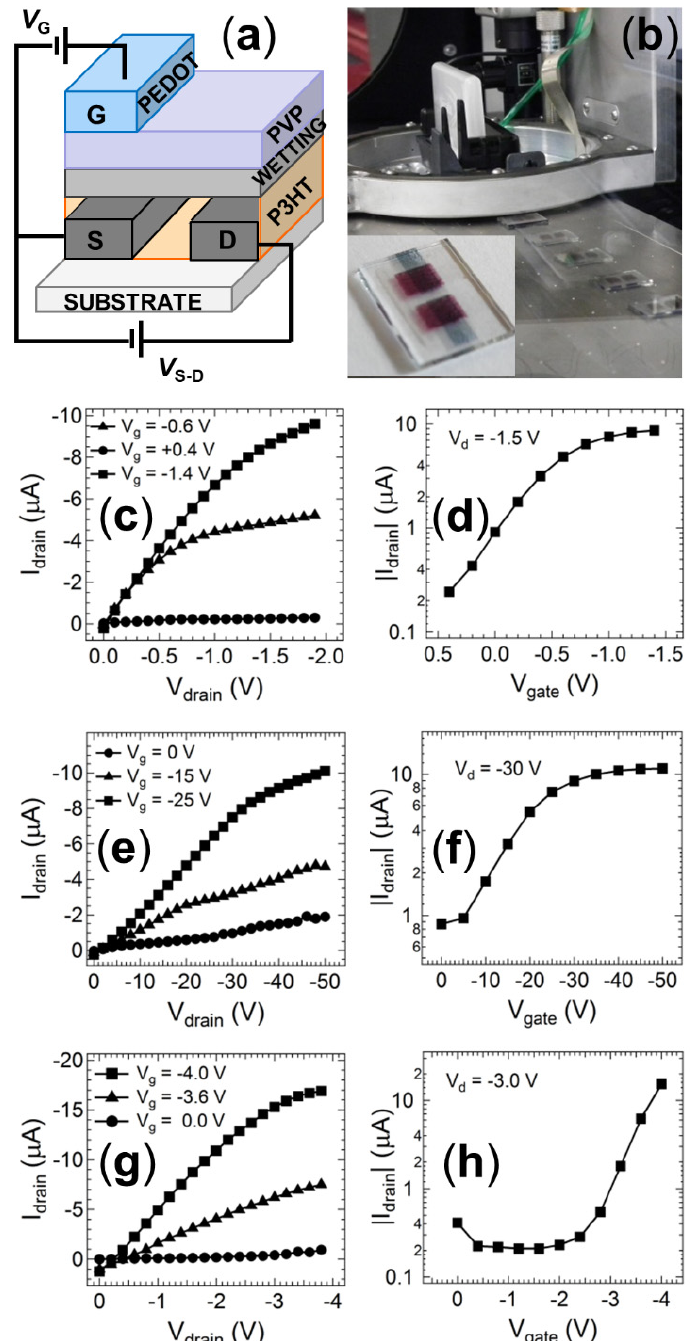
Figure 4. ( a ) Schematic diagram of the modified organic thin film transistor (OTFT) structure employed for inkjet-printed samples. ( b ) Photographs of the inkjet fabrication of multiple samples simultaneously. The inset shows a magnified view of a fully printed OTFT. ( c ) Output characteristic and ( d ) transfer characteristics of the OTFT structure shown in ( a ) fabricated using spin-coated films with a ZnO wetting layer. ( e ) Output characteristic and ( f ) transfer characteristics of the OTFT structure shown in ( a ) fabricated using inkjet-printed films with a ZnO wetting layer. ( g ) Output characteristic and ( h ) transfer characteristics of the OTFT structure shown in ( a ) fabricated using inkjet-printed films with a PVP wetting layer printing from 2-propanol.